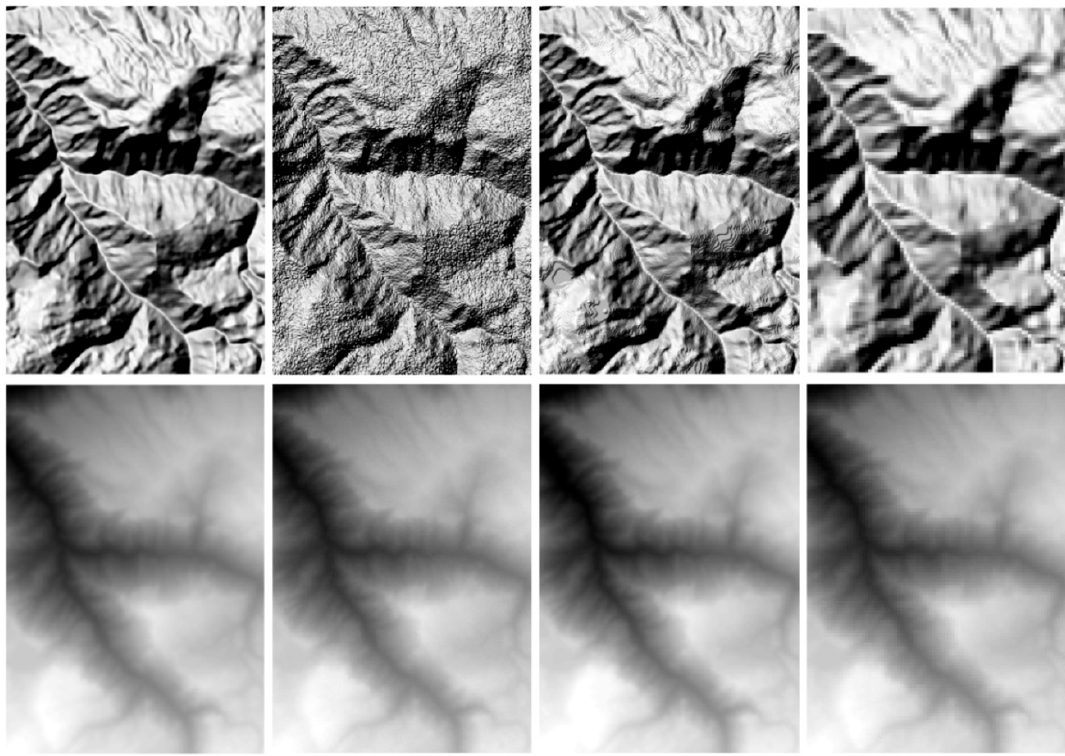
Figure 8. Comparison of hillshade ( top ) and hypsometry ( bottom ) for DEM artifact detection (from left to right: original DEM, DEM with Gaussian noise, 8-bit coded DEM, DEM subsampled 4 times). Source: DEM produced by contour-line interpolation in a 1:20,000 topographic map of Lebanon.